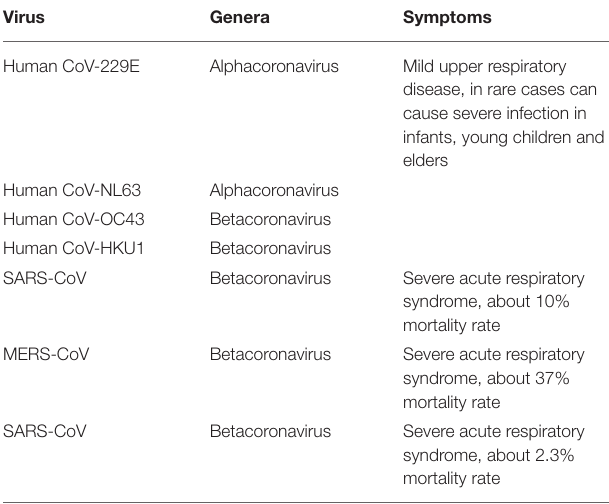
TABLE 1 | List of seven CoVs known to infect human. Virus Genera Symptoms Human CoV-229E Mild upper respiratory